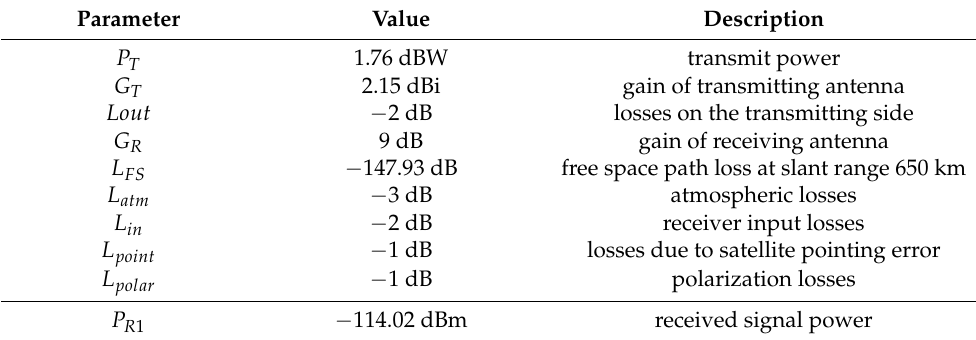
Table 1. Parameters used for the link